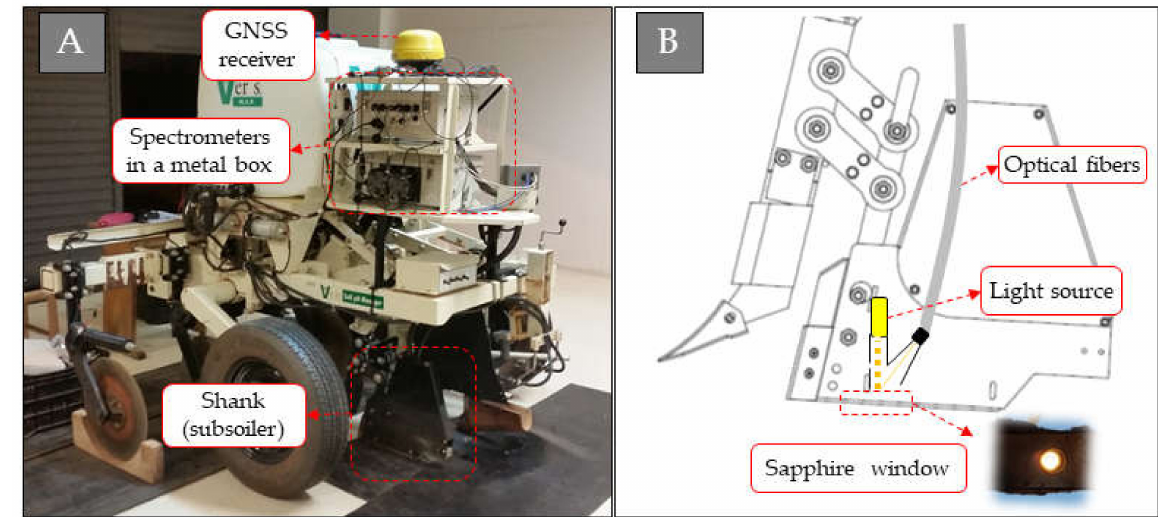
Figure 2. Mobile vis–NIR platform ( A ) and its shank in detail ( B